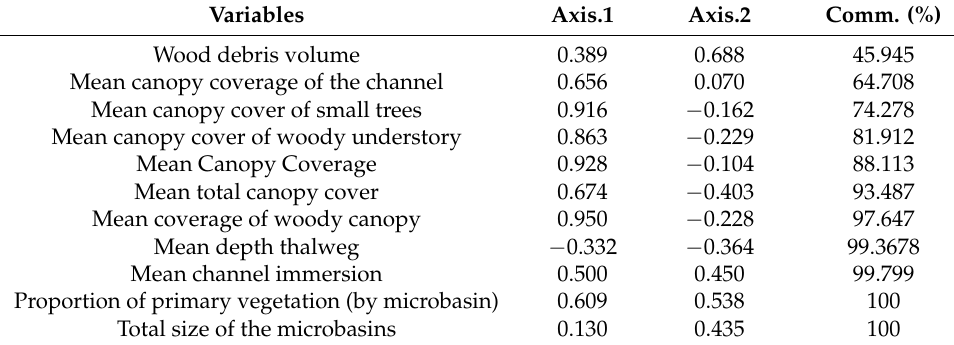
Table 1. Results of the Principal Components Analysis (PCA) performed on the correlation matrix of the environmental variables describing the cover of different habitat types.